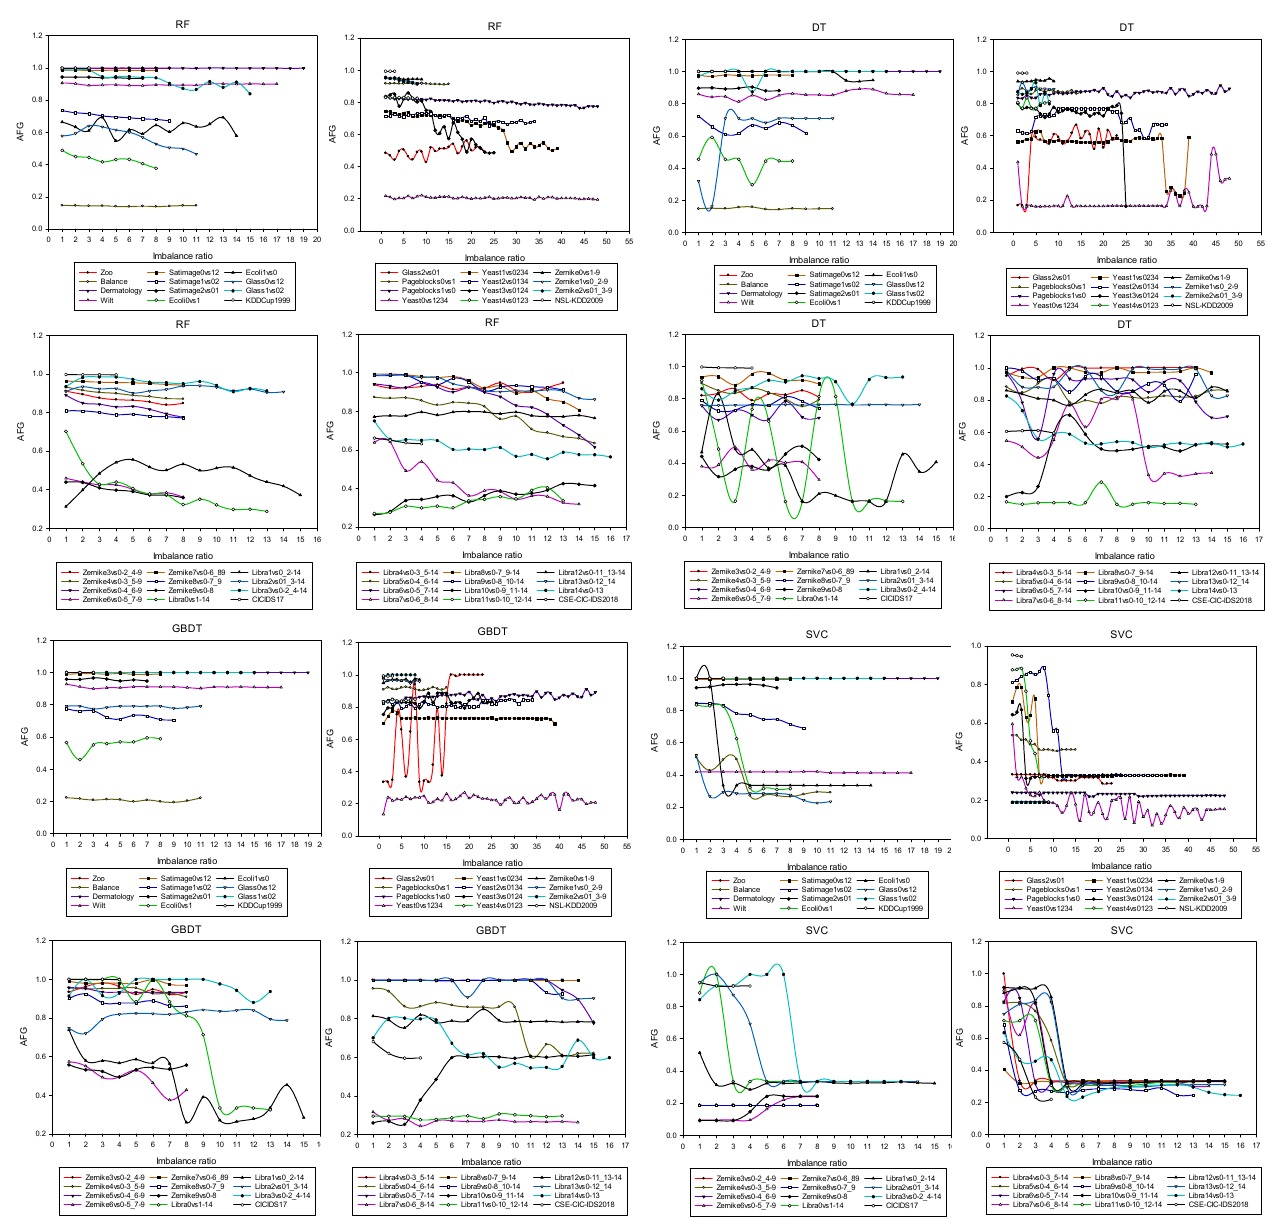
Figure 8. Relationship between varying performance in RF, DT, GBDT, SVC and